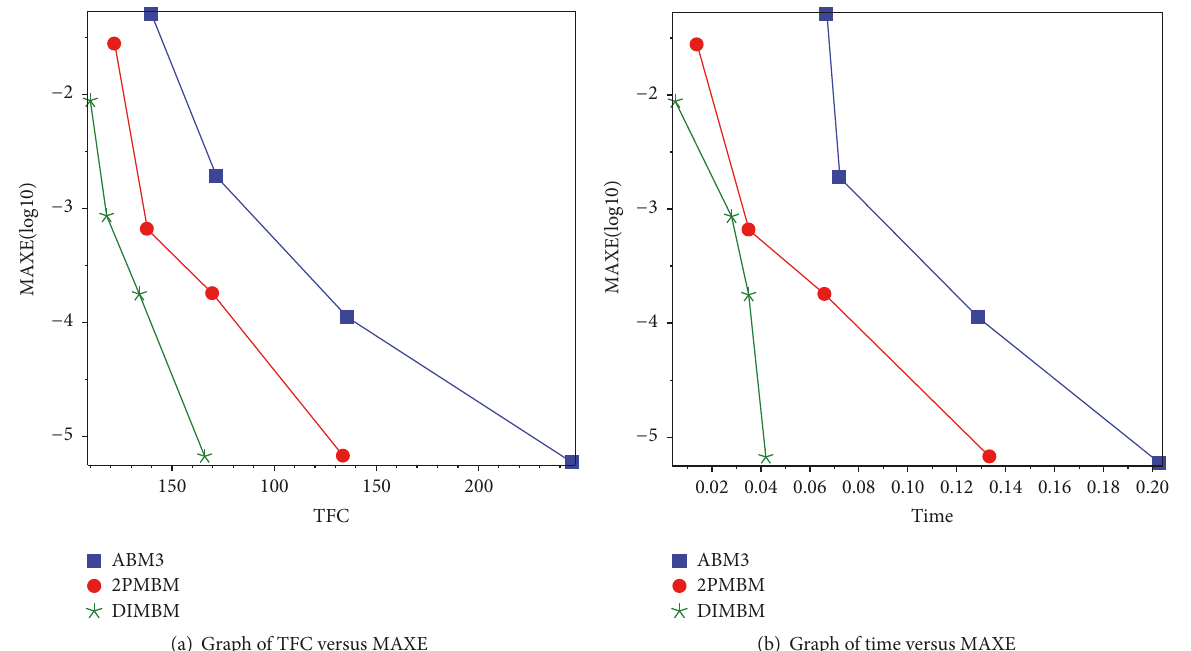
Figure 6: Graph of the numerical results when solving Example